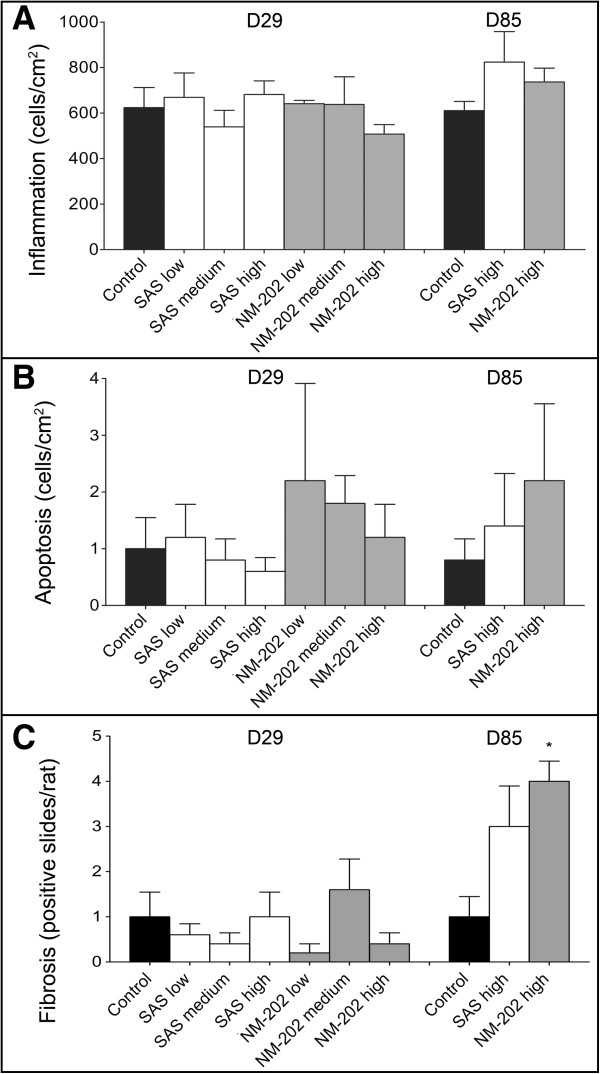
Histopathological evaluation of livers from animals treated with SAS or NM-202 for 28 or 84 days. (A) The number of mononuclear inflammatory cells (given per cm2) in liver tissue after 28-, or 84-days of exposure (mean ± standard error of the mean; n = 5). (B) The number of apoptotic cells (given per cm2) in liver tissue after 28-, or 84-days of exposure (mean ± standard error of the mean; n = 5). (C) The number of slides (out of a maximum of 10 evaluated slides) in which fibrosis occurred. * Significant difference versus the control at that day.